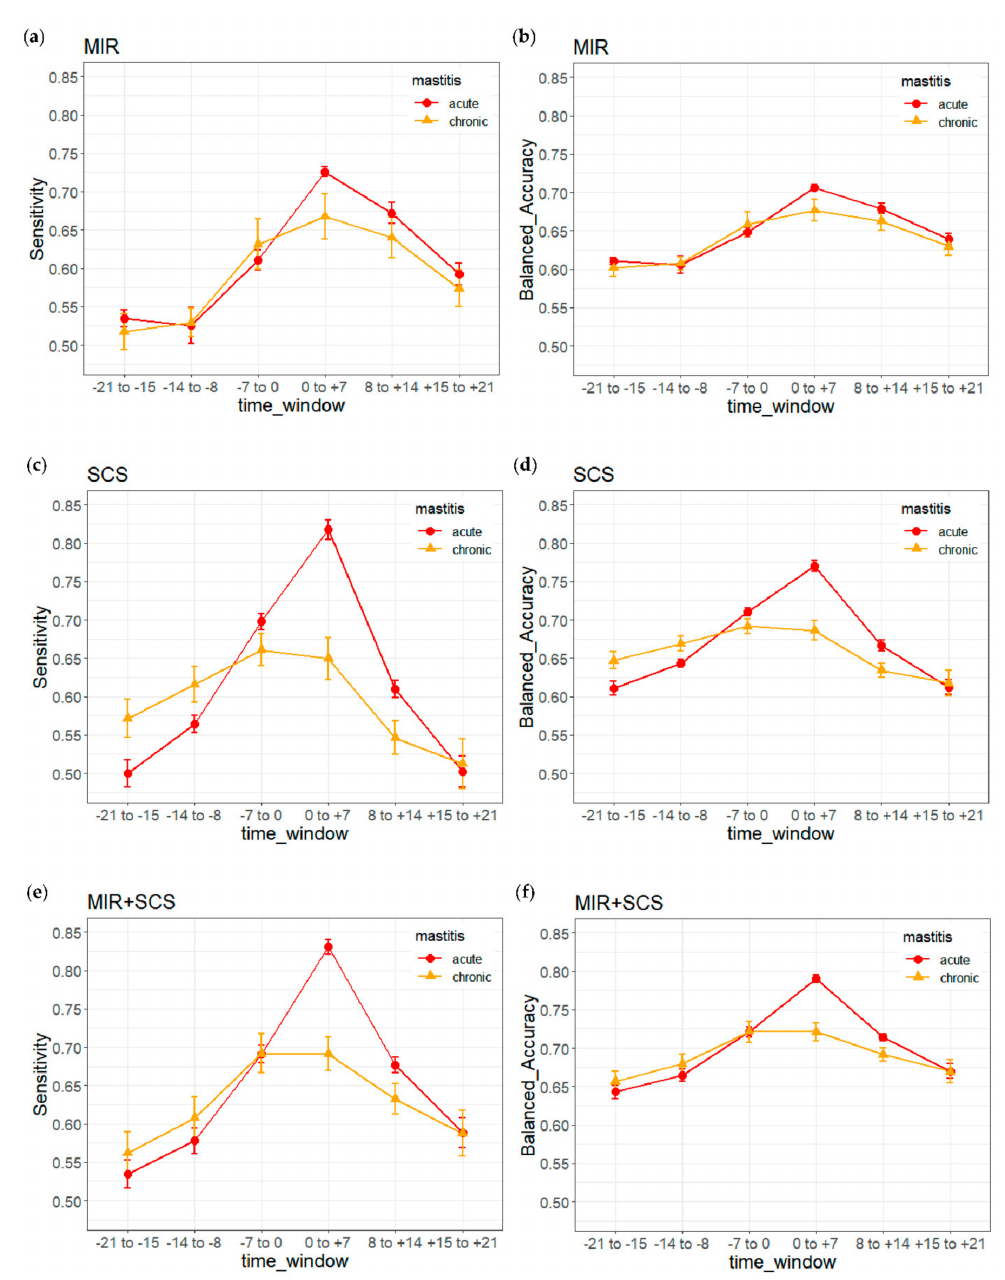
Figure 3. Sensitivities and balanced accuracies for models based on different predictor variables (MIR, SCS, MIR + SCS) against the validation dataset as a function of time windows before or after mastitis diagnosis: sensitivities of MIR ( a ), balanced accuracies of MIR ( b ), sensitivities of SCS ( c ), balanced accuracies of SCS ( d ), sensitivities of MIR + SCS ( e ), balanced accuracies of MIR + SCS ( f ). Means and 95% confidence intervals from 10 independent runs are